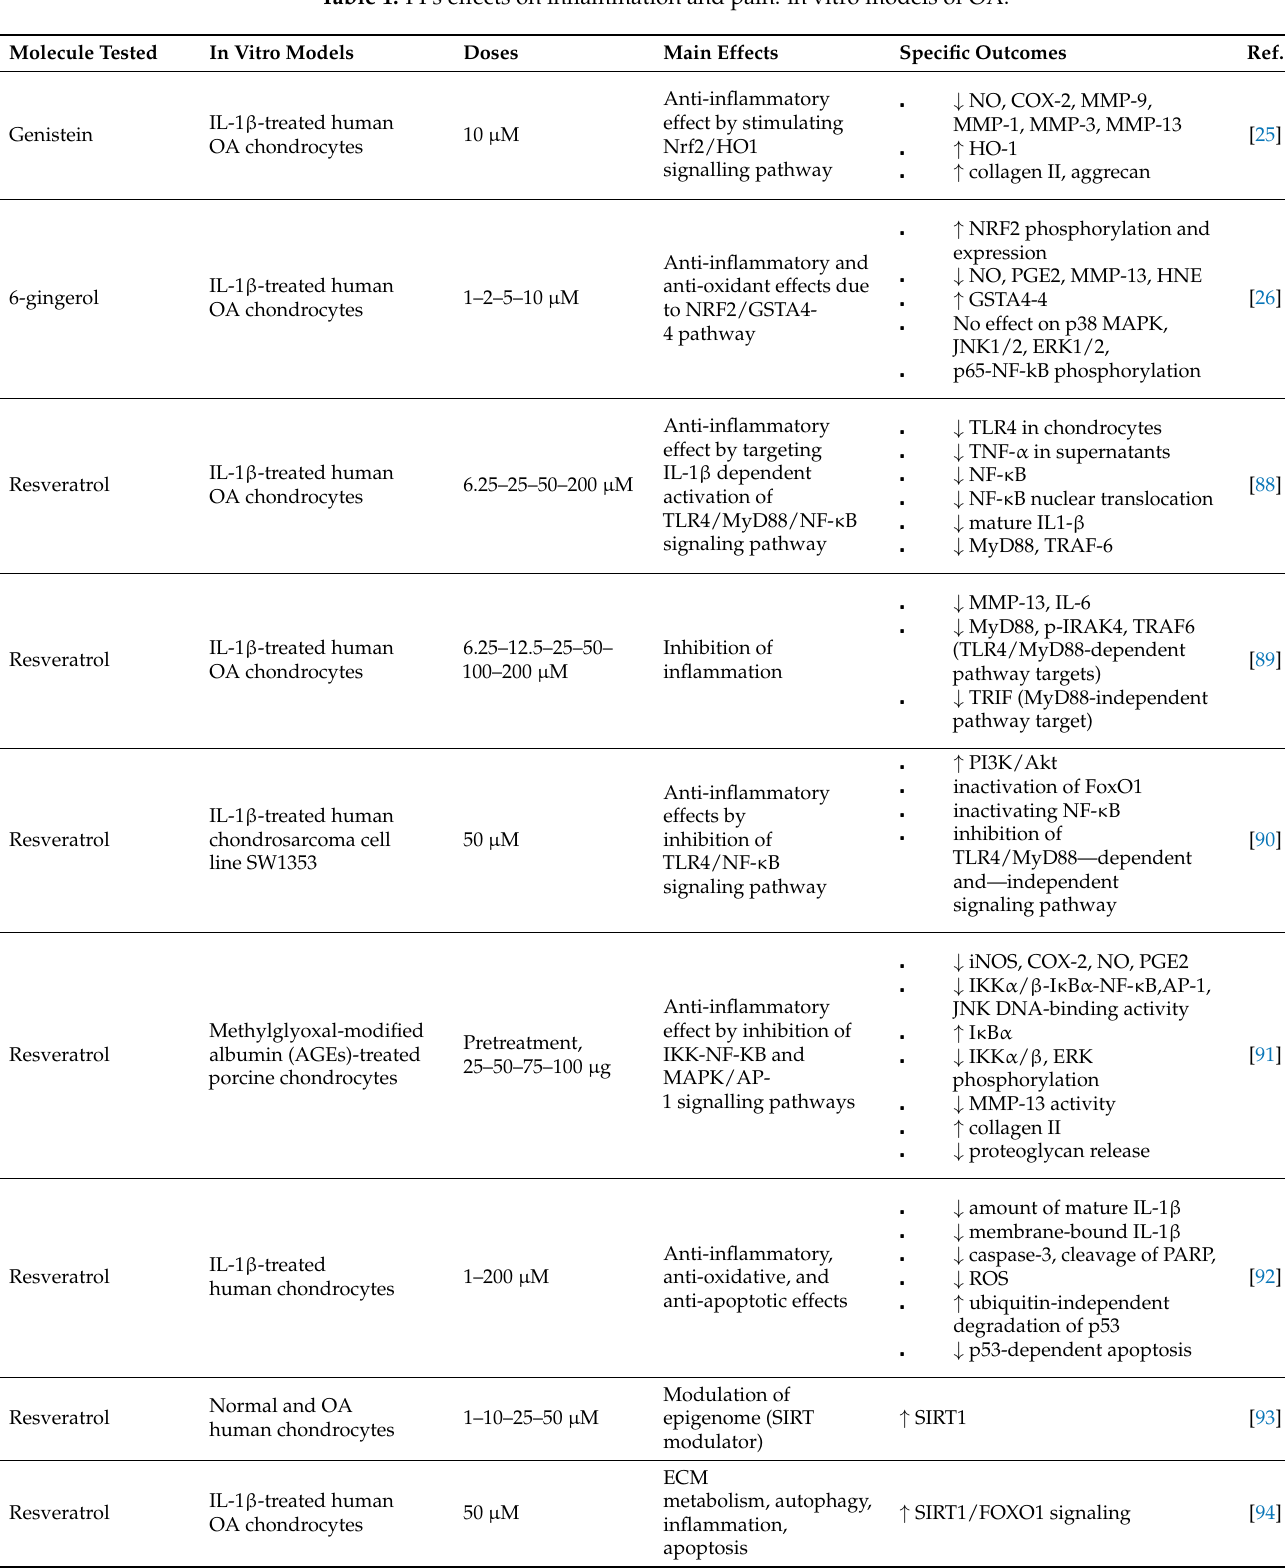
Table 1. PPs effects on inflammation and pain: in vitro models of